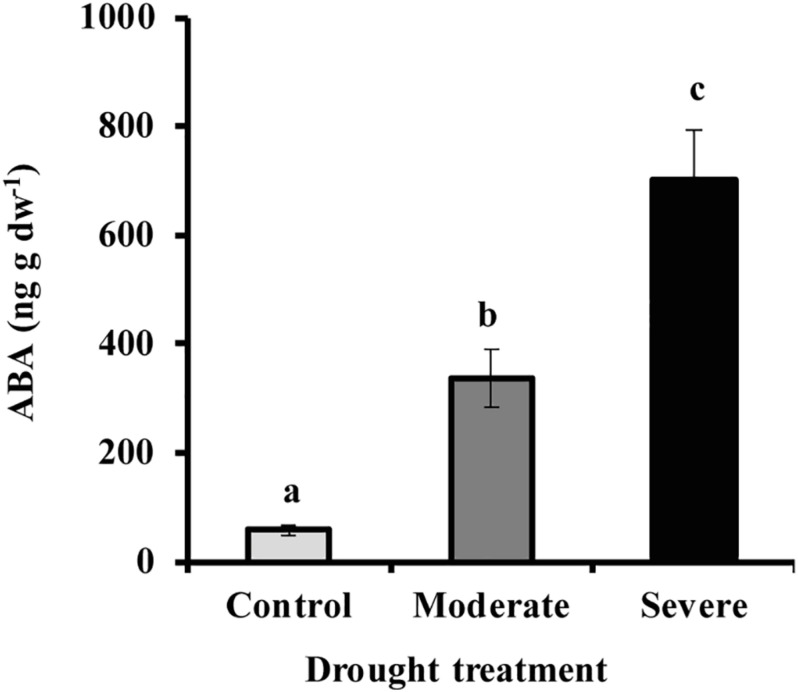
Drought increased needle ABA content under moderate and severe drought conditions. Data shown are means of five biological replicate ± SE. Different letters indicate significant differences at P < 0.05.